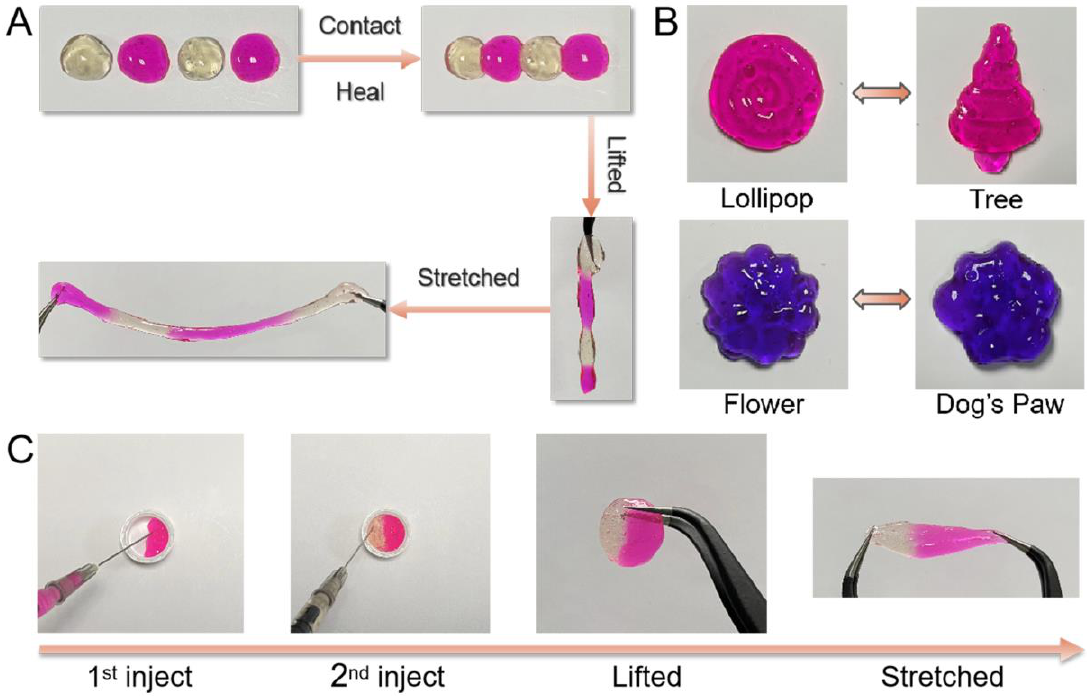
Figure 3. ( A ) Self-healing, ( B ) Remolding, and ( C ) Injectable properties of Alg-BOB hydrogel.